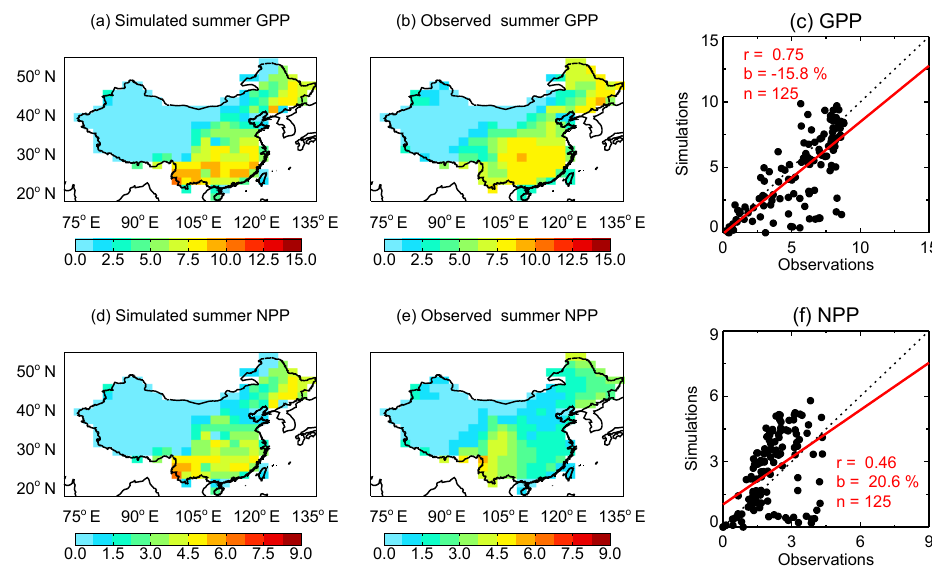
Figure 1. Evaluation of simulated summertime carbon fluxes by ModelE2–YIBs. Panels show GPP (top row) and NPP (bottom row) over China. Simulation results (a, d) are the average of G10ALLHO3 and G10ALLLO3, which are performed with the climate model ModelE2– YIBs using high and low ozone damage sensitivities (Table 2). The correlation coefficients ( r ), relative biases ( b ), and number of grid cells ( n ) for the comparisons are listed on the scatter plots. Units: gCm − 2 day − 1